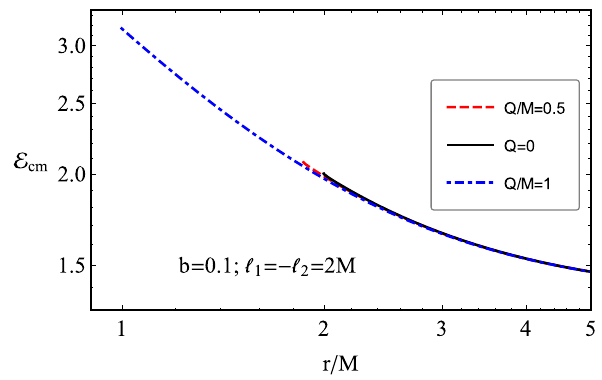
Fig. 15 Dependenceofcenter-of-massenergyofcollisionsofthemag- netized particles, with the parameter b = 0 . 1, and a neutral particle having the same initial energy E 1 = E 2 = 1, in the vicinity of the elec- trically charged RN black hole for the different values of the black hole